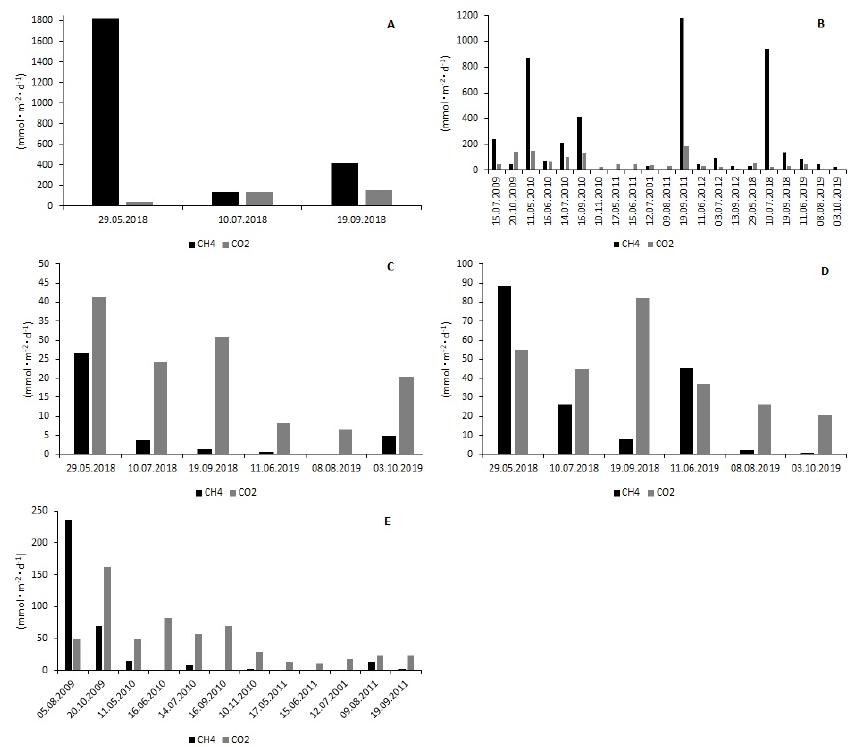
Figure 3. Time series of CH 4 and CO 2 fluxes at the water–air interface in Rzeszów Reservoir (panel A—station R1, panel B—R2, panel C—R3, panel D—R4 and panel E—R5).